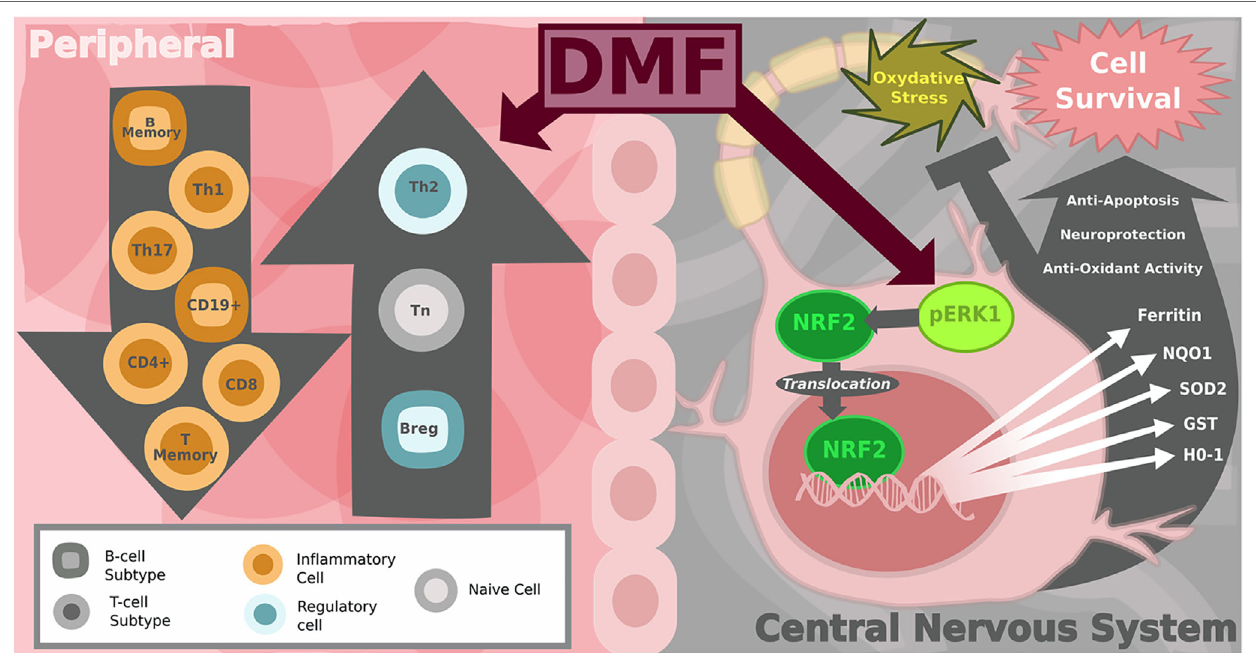
FiGURe 2 | Diagram of peripheral immune and central nervous system (CNS) effects of dimethyl fumarate (DMF) in multiple sclerosis (MS). On the left: the shift in the balance toward anti-inflammatory immune cells in the peripheral blood. DMF-treated MS patients show a reduction in CD8 + and to lesser extent CD4 + T-cells as well as a decrease in the number of CD19 + B-cells. Subset analysis reveals that total B and T memory cells decline while the number of naïve T-cells increases. Pro-inflammatory T helper subsets Th1 and Th17 decrease, shifting the balance toward more anti-inflammatory Th2, T-regulatory and B-regulatory subsets. On the right: within the CNS, DMF and its metabolites are activators of the Nrf2-dependent intracellular pathway, which protects neurons from oxidative stress. Nrf2 translocates from the cytoplasm to the nucleus to increase transcription of genes encoding antioxidant enzymes, including: heme oxygenase-1 (HO-1), NAD(P)H quinone dehydrogenase 1 (NQO1), GSTP1 (others glutathione-S-transferase), superoxide dismutase-2 (SOD2), Sulfiredoxin-1 (SRXN1), ferritin heavy chain 1 (FTH1). Image copyright Caitlyn Fisher and Yang Mao-Draayer reprints with